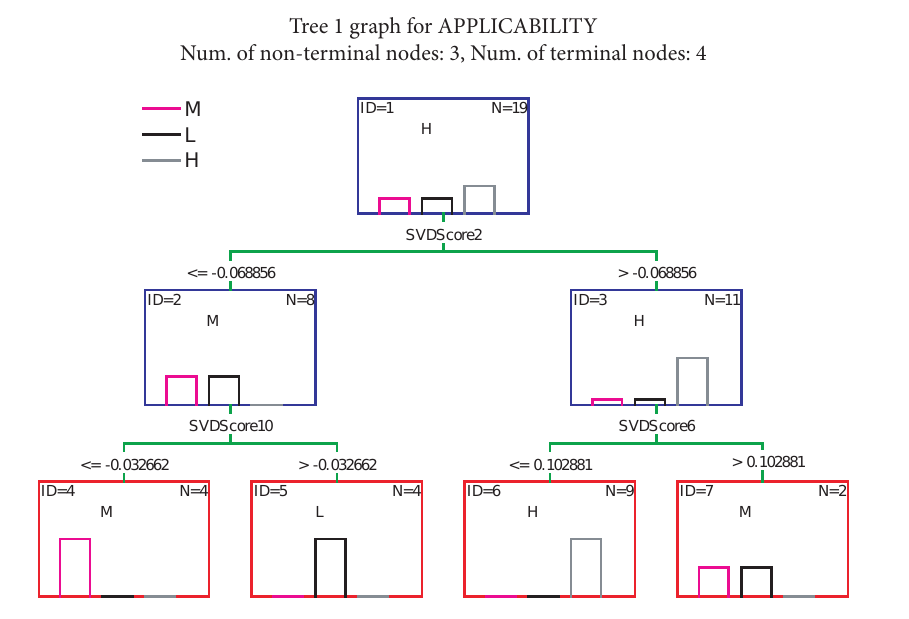
Fig. 11. Decision (classification) tree